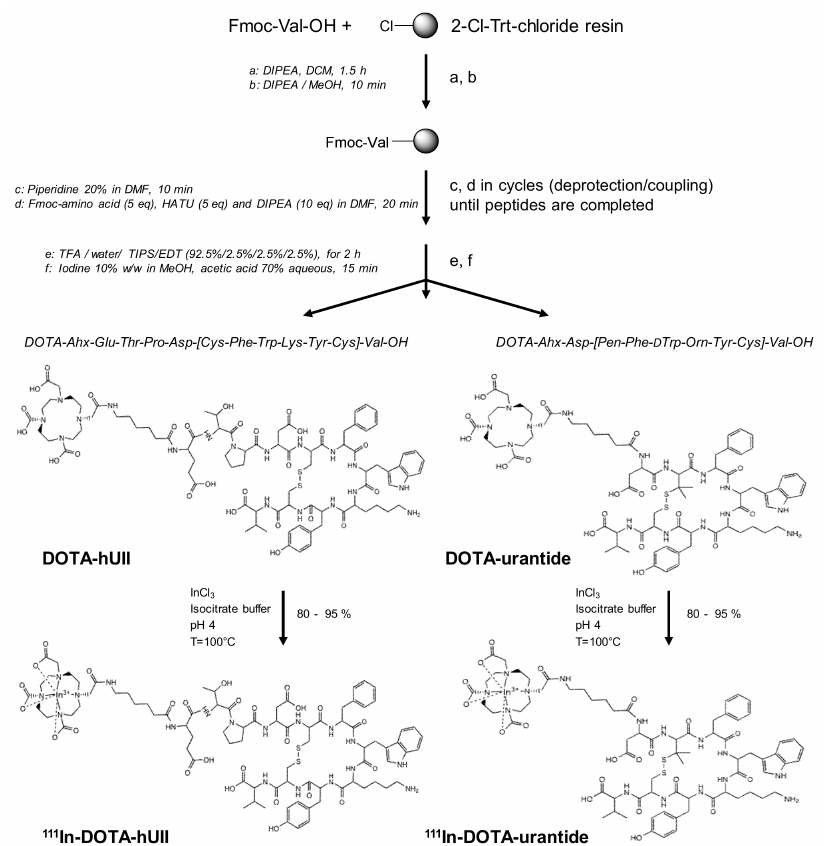
Figure 1. Synthesis and radiolabelling of DOTA-hUII and DOTA-urantide. Synthesis of hUII or urantide and coupling of the DOTA-chelator at the N-terminus of the analogues leading to DOTA-hUII (DOTA-Ahx-ETPD[CFWKYC]V) and DOTA-urantide (DOTA-Ahx-D[Pen-F-W-Orn-YC]V). Then, radiolabelling with 111 Indium was carried out in isocitrate bu ff er, at pH 4 and 100 ◦ C. ACN: